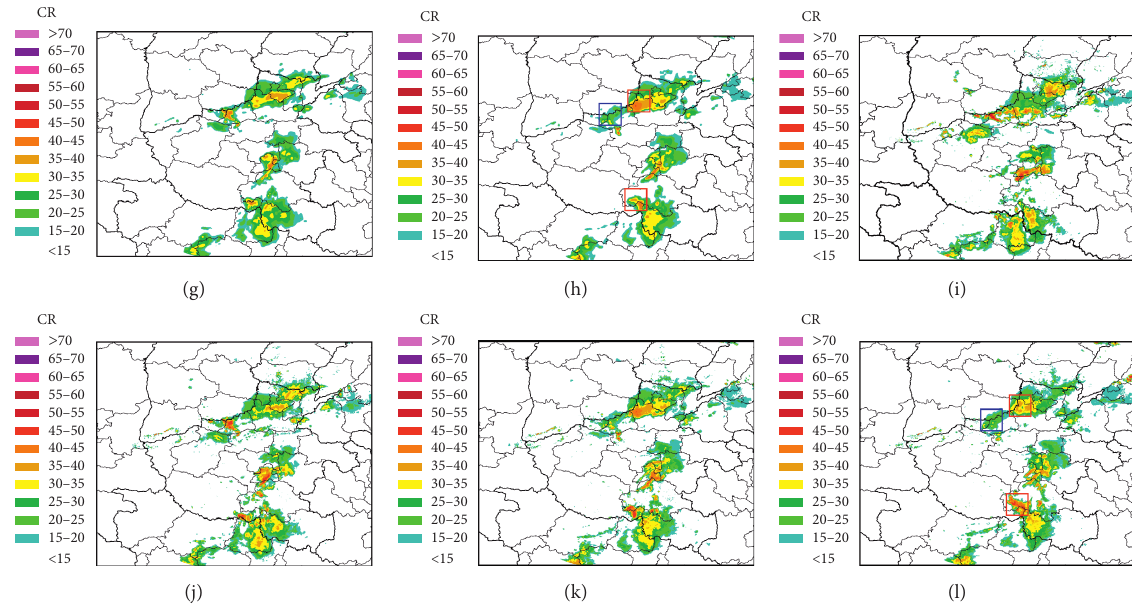
Figure 6: Comparison between the composite reflectivity factor forecast results and the actual weather conditions for the 2h starting at 1100UTC July 14 2017. The forecast results of the optical flow method: (a) 30min, (b) 60min, (c) 90min, and (d) 120min after the start time of 1100UTC, respectively; the forecast results of the ConvLSTM method: (e) 30min, (f) 60 min, (g) 90 min, and (h) 120min after the start time of 1100UTC, respectively; the actual weather conditions: (i) 30min, (j) 60min, (k) 90 min, and (l) 120min after the start time of 1100UTC, respectively; red square lines represents the enhancement area of observe radar echoes and blue square lines for the weakened